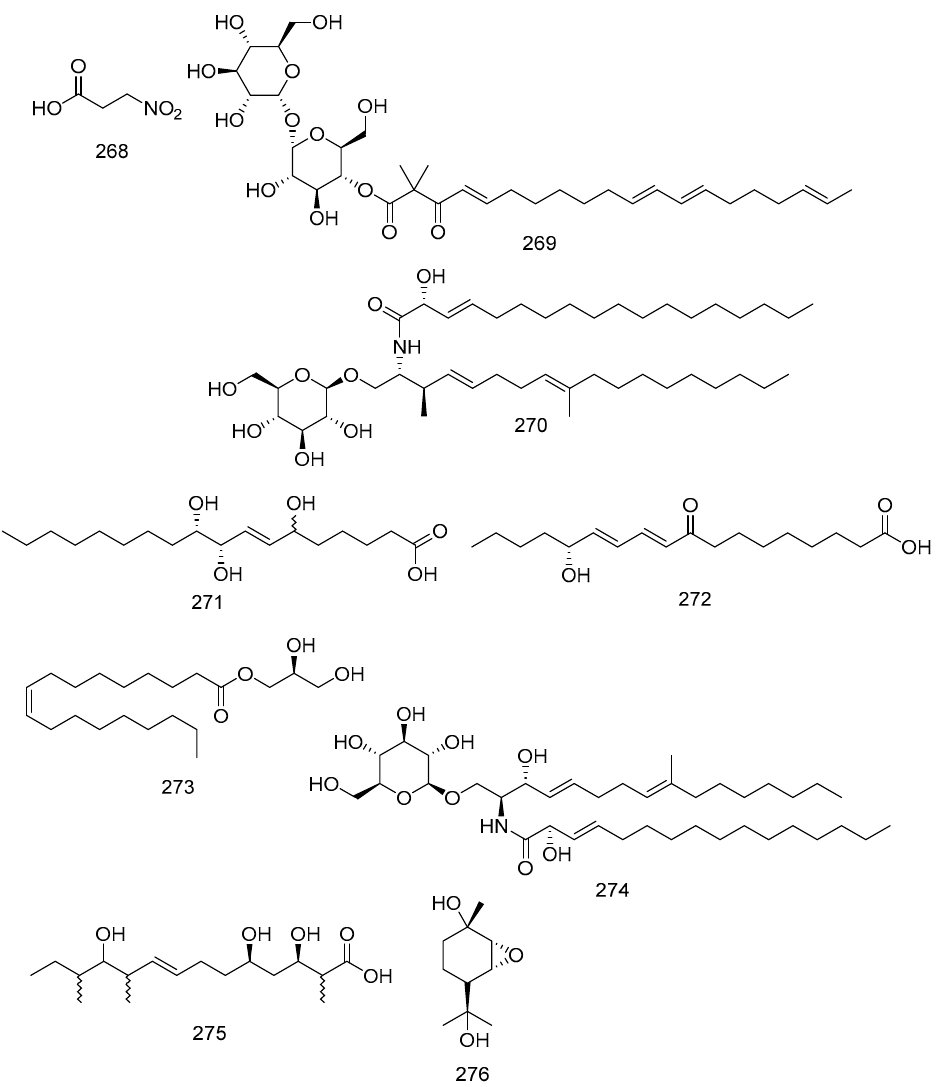
Figure 12. Nitro compound ( 268 ), fatty acid, and sugars ( 269 – 276 ) characterized by endophytic fungi in